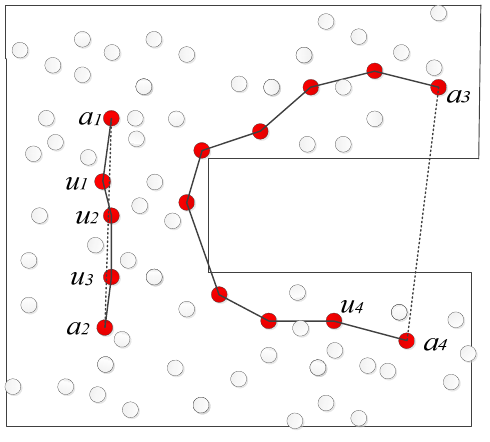
Figure 4. Schematic diagram of the multi-hop shortest path between nodes.